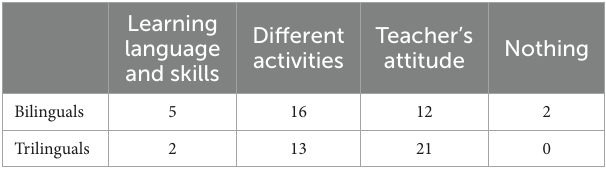
TABLE 3 Themes emerged as an answer to question